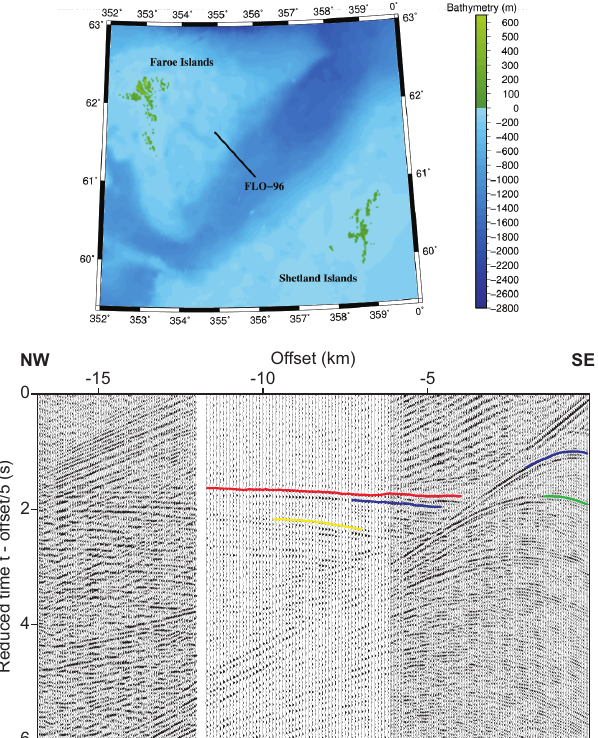
Fig. 4. Survey FLO-96. Location map of the profile (top), and Figure 4. Survey FLO-96. Location map of the profile (top), and shotgather (bottom). In the shot gather the NW corresponds to the shotgather (bottom). In the shot gather the NW corresponds to the left and the SE to the right The following phases are identified: sea left and the SE to the right The following phases are identified: sea bottom reflection (blue), top-basalt reflection (green), basalt refrac- bottom reflection (blue), top-basalt reflection (green), basalt refrac- tion (red), base-basalt reflection (purple) and top-basement reflec- tion (red), base-basalt reflection (purple) and top-basement reflec- tion (yellow). This shotgather is a composite from the two-ship tion (yellow). This shotgather is a composite from the two-ship experiment (see the text for an experiment (see the text for an explanation).